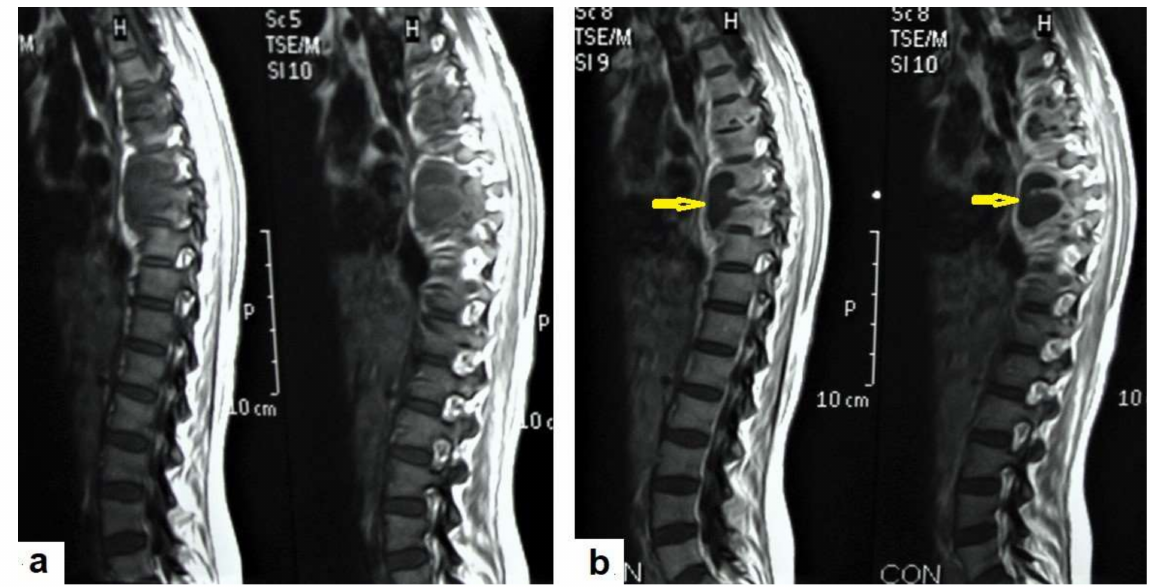
Figure 18. Pott’s disease in a 28-year-old female. Selected images of sagittal MRI of thoracic spine show destructive lesion affects multiple contiguous thoracic vertebrae with paraspinal collection. ( a ) Pre- contrast and ( b ) post-contrast T1-weighted images show subligamentous spread of the infection to involve five vertebrae with peripheral enhancement of the lesions, suggesting an abscess